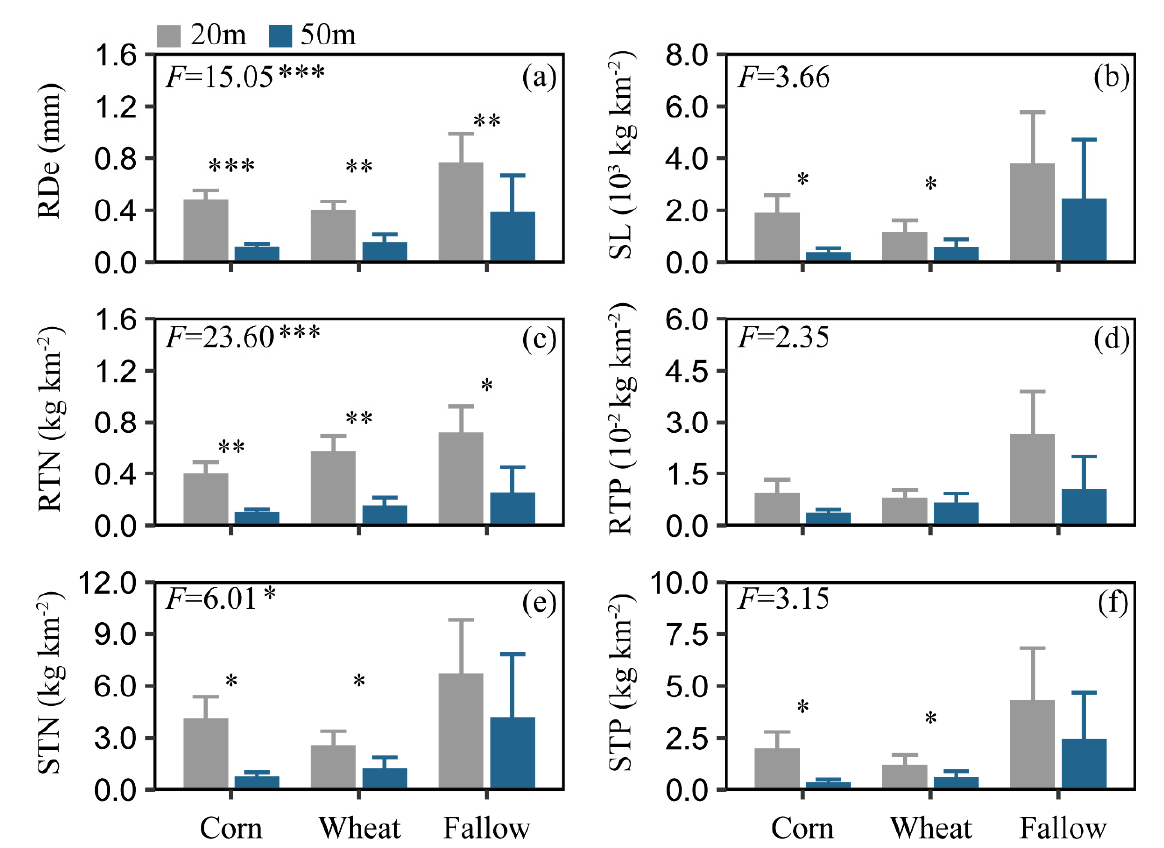
Figure 5. The ( a ) runoff depth (RDe), ( b ) soil loss (SL), ( c ) total nitrogen in runoff (RTN), ( d ) total phosphorus in runoff (RTP), ( e ) total nitrogen in soil loss (STN), and ( f ) total phosphorus in soil loss (STP) for slope lengths of 20 and 50 m. The significance value in the upper left corner represents the results of the analysis of all crops. *, p < 0.05; **, p < 0.01; *** p < 0.001.